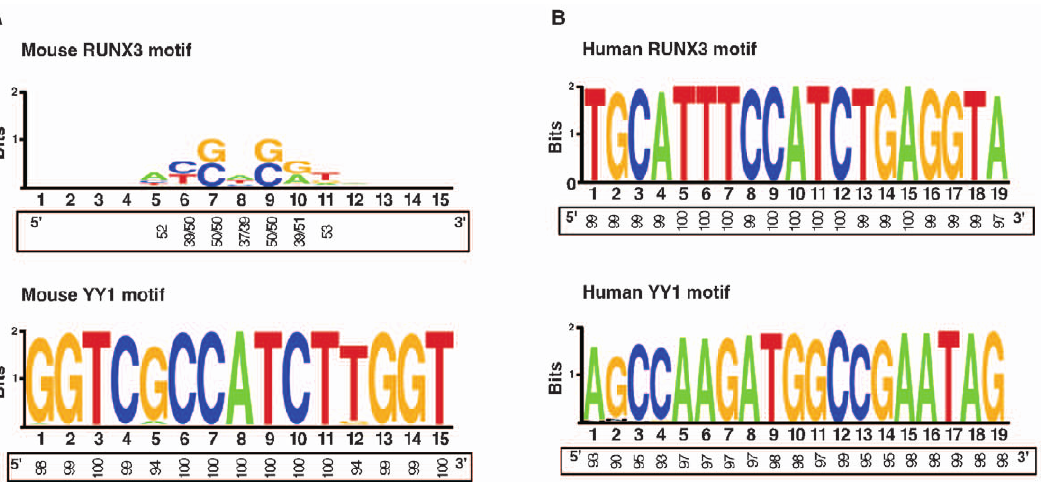
Figure 4. Characterization of the RUNX3 and YY1 transcription binding sites in both mouse and human L1 promoters. ( A ) Graphical representations of the mouse RUNX3 (Top panel) and YY1 (Bottom panel) sequence patterns within a sequence alignment of 819 T F elements containing the 3,152 YY1 binding sites. The height of each stack indicates the sequence conservation (measured in bits) and the relative frequency of the nucleotides is shown on the x-axis. Note: RUNX3 motifs in mouse L1 elements are highly mutated and degenerated. ( B ) Graphical representations of the human RUNX3 (Top panel) and YY1 (Bottom panel) sequence patterns within a sequence alignment of 150 L1 elements containing both the RUNX3 and YY1 binding sites. The relative frequency of each nucleotide within the motifs is shown on the x-axis.